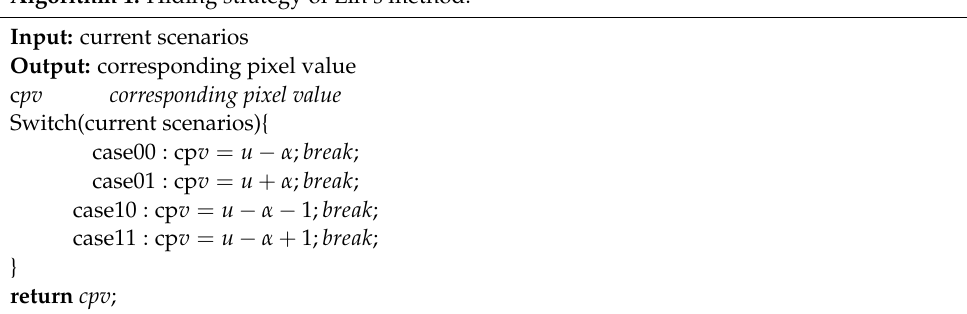
Algorithm 1. Hiding strategy of Lin’s method.